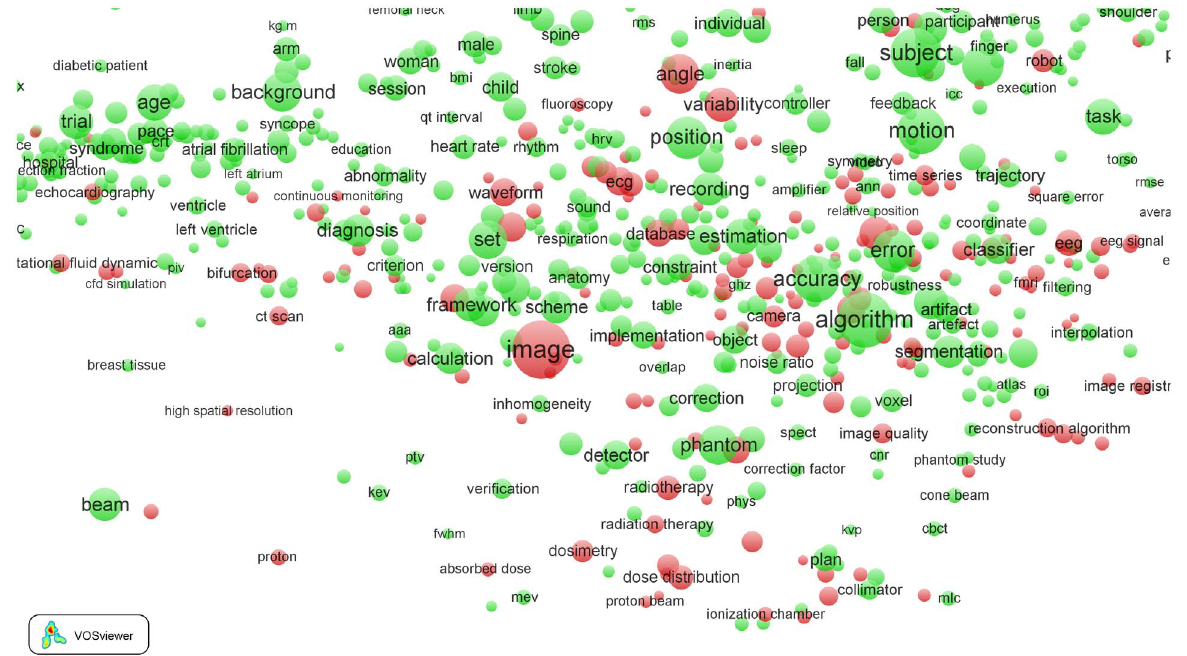
Figure 10. Term map of the Biomedicalengineering field after zooming in into the imaging and radiation therapy subfield.